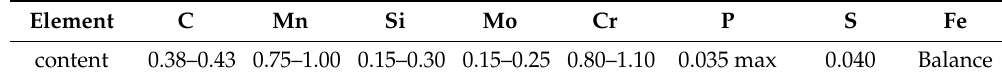
Table 2. Chemical component of AISI 4140 steel